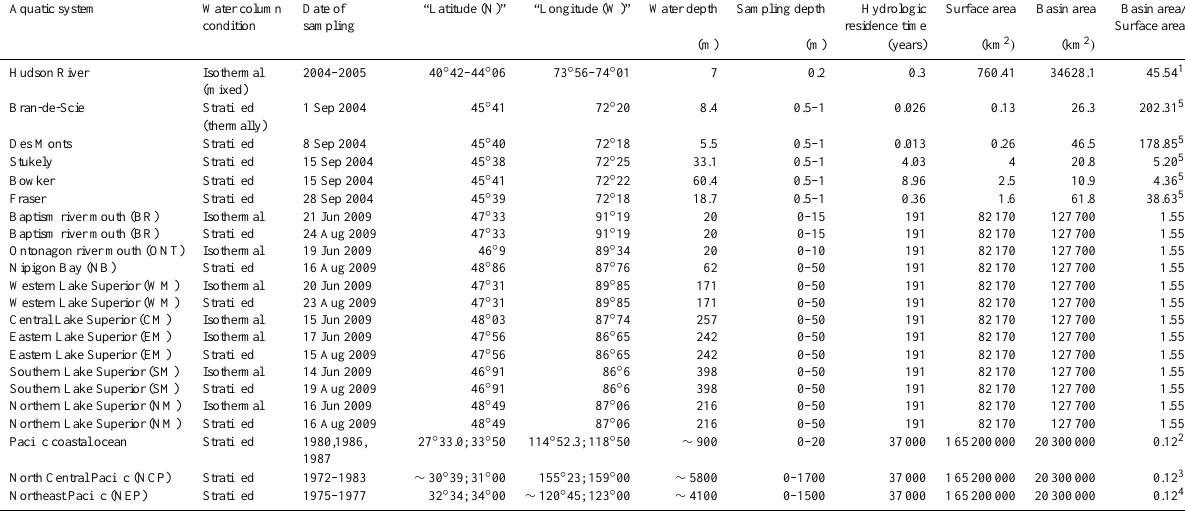
Table 1. Coordinates, sampling depths, hydrologic residence, basin area, and surface areas of the rivers, small lakes, Lake Superior and the Pacific Ocean. nd=not determined or not known.